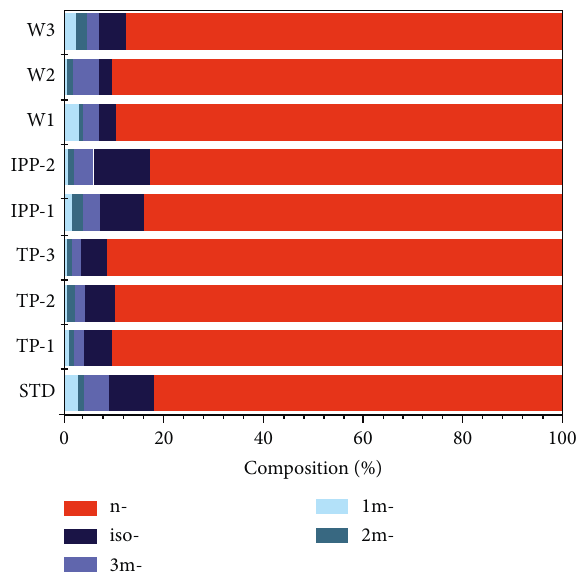
Figure 5: Comparison of the isomer proportions of PFHxS in three technical products (a Bidepharm; b CNW; c J&K Scientific) measured by NMR and LC/MS independently.